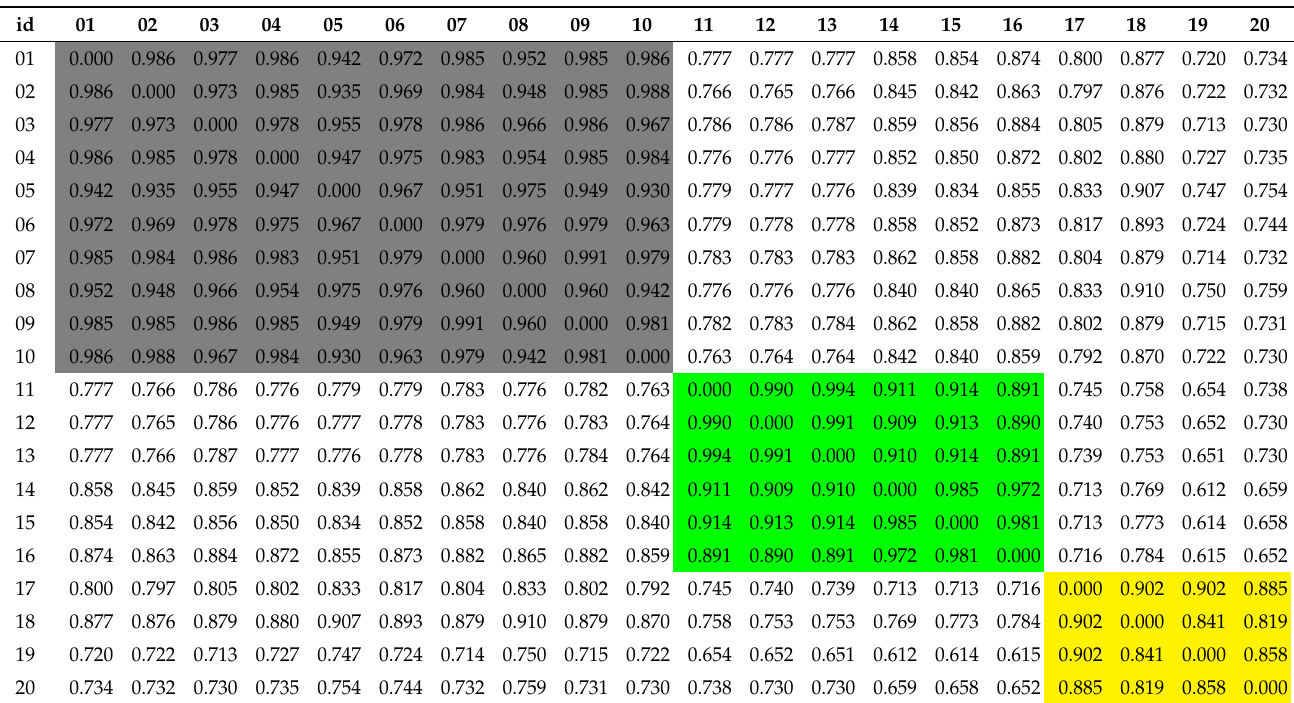
Table 4. The affinity matrix W B of B-phase voltage sag